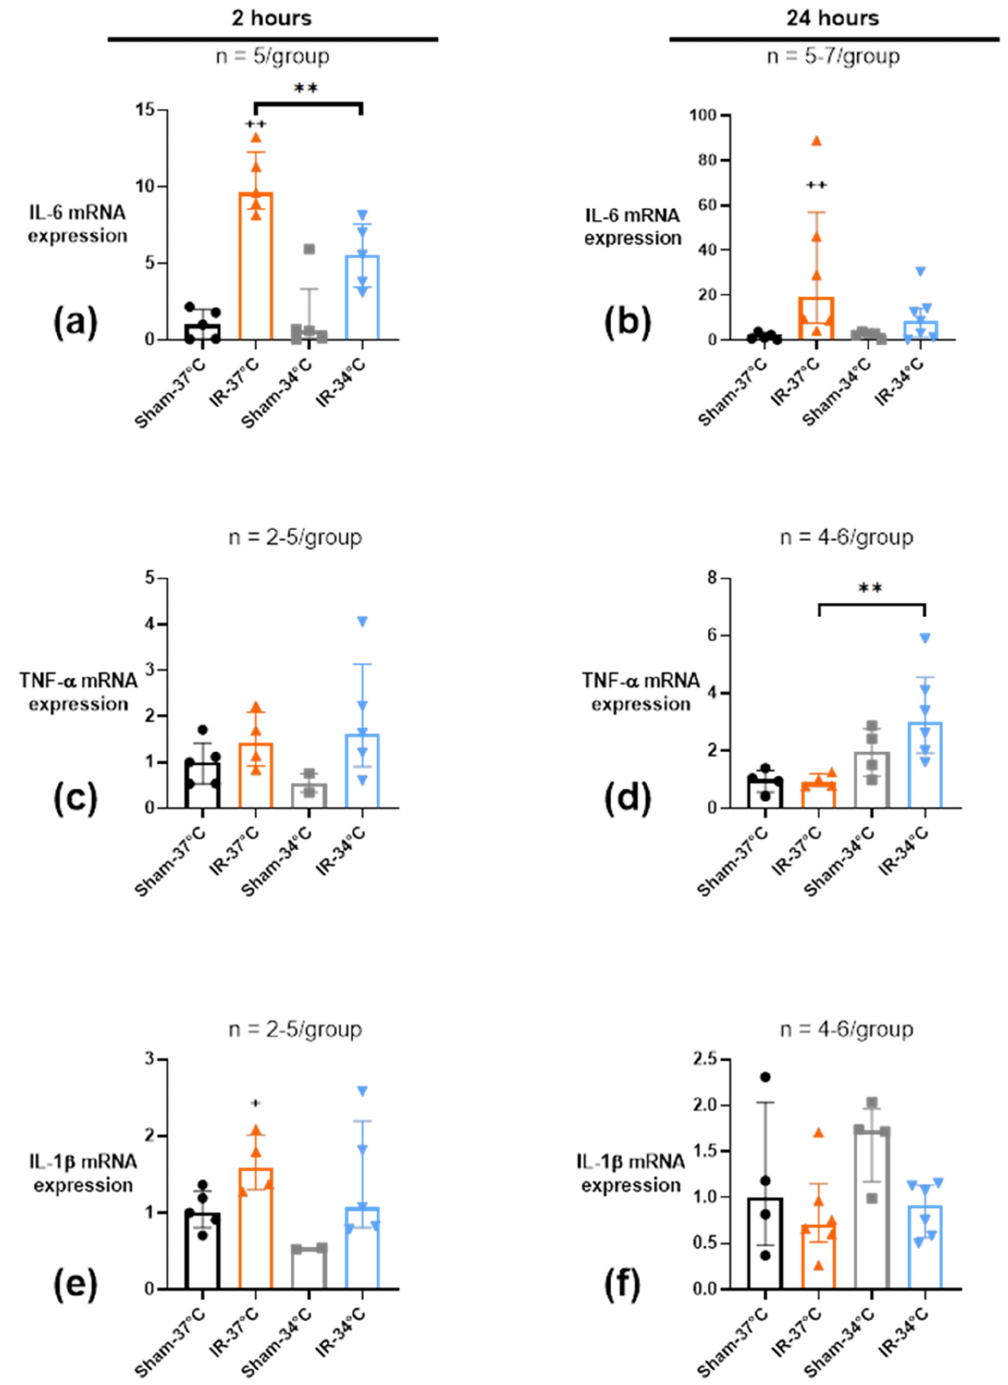
Figure 6. mRNA expression of inflammatory markers IL-6 ( a , b ), TNF- α ( c , d ) and IL-1 β ( e , f ) in kidney tissue after 20 min of bilateral renal ischemia where the mice body temperature was maintained at normothermia (IR-37 ◦ C) or at mild therapeutic hypothermia (mTH) (IR-34 ◦ C), and 2 h or 24 h of reperfusion, or after a Sham procedure with the same body temperature (Sham-37 ◦ C and Sham- 34 ◦ C). Renal IR induced an overexpression of IL-6 and IL-1 β after 2 h of reperfusion, that was maintained after 24 h only for IL-6. However, mTH during ischemia prevented them, but induced the overexpression of TNF- α 24 h after reperfusion. Actin mRNA was used as an internal standard to normalize the abundance of cDNA in each sample to normalize results. Data are shown as median with interquartiles. ** p < 0.01, Mann–Whitney test. + p < 0.05, ++ p < 0.01 vs. Sham-37 ◦ C, Mann–Whitney